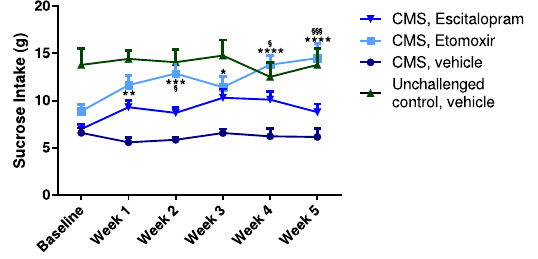
Figure 1. Comparison over time of the efficacy of Etomoxir and Escitalopram in chronic mild stress-induced depression. Baseline values indicate sucrose intake after four weeks of stress exposure. Sucrose intake in gram during five weeks of treatment with Escitalopram (n = 14, downwards triangle), Etomoxir (n = 20, square) or vehicle (n = 9, circle) with continuous chronic mild stress exposure. Unchallenged control group was not exposed to the stress protocol but received vehicle treatment (n = 9, triangle). All data are presented as mean ± SEM. The results from the repeated measures two-way ANOVA (interaction F = 2.31, DF = 15, p = 0.0043; time F = 2.21, DF = 5, p = 0.0535; treatment F = 13.63, DF = 3, p < 0.0001) with Tukey multiple comparisons post hoc test showed statistical significance between vehicle and Etomoxir ( * ), and Escitalopram and Etomoxir (§). Number of asterisks/paragraphs indicates level of statistical significance ( * p = 0.01–0.05,